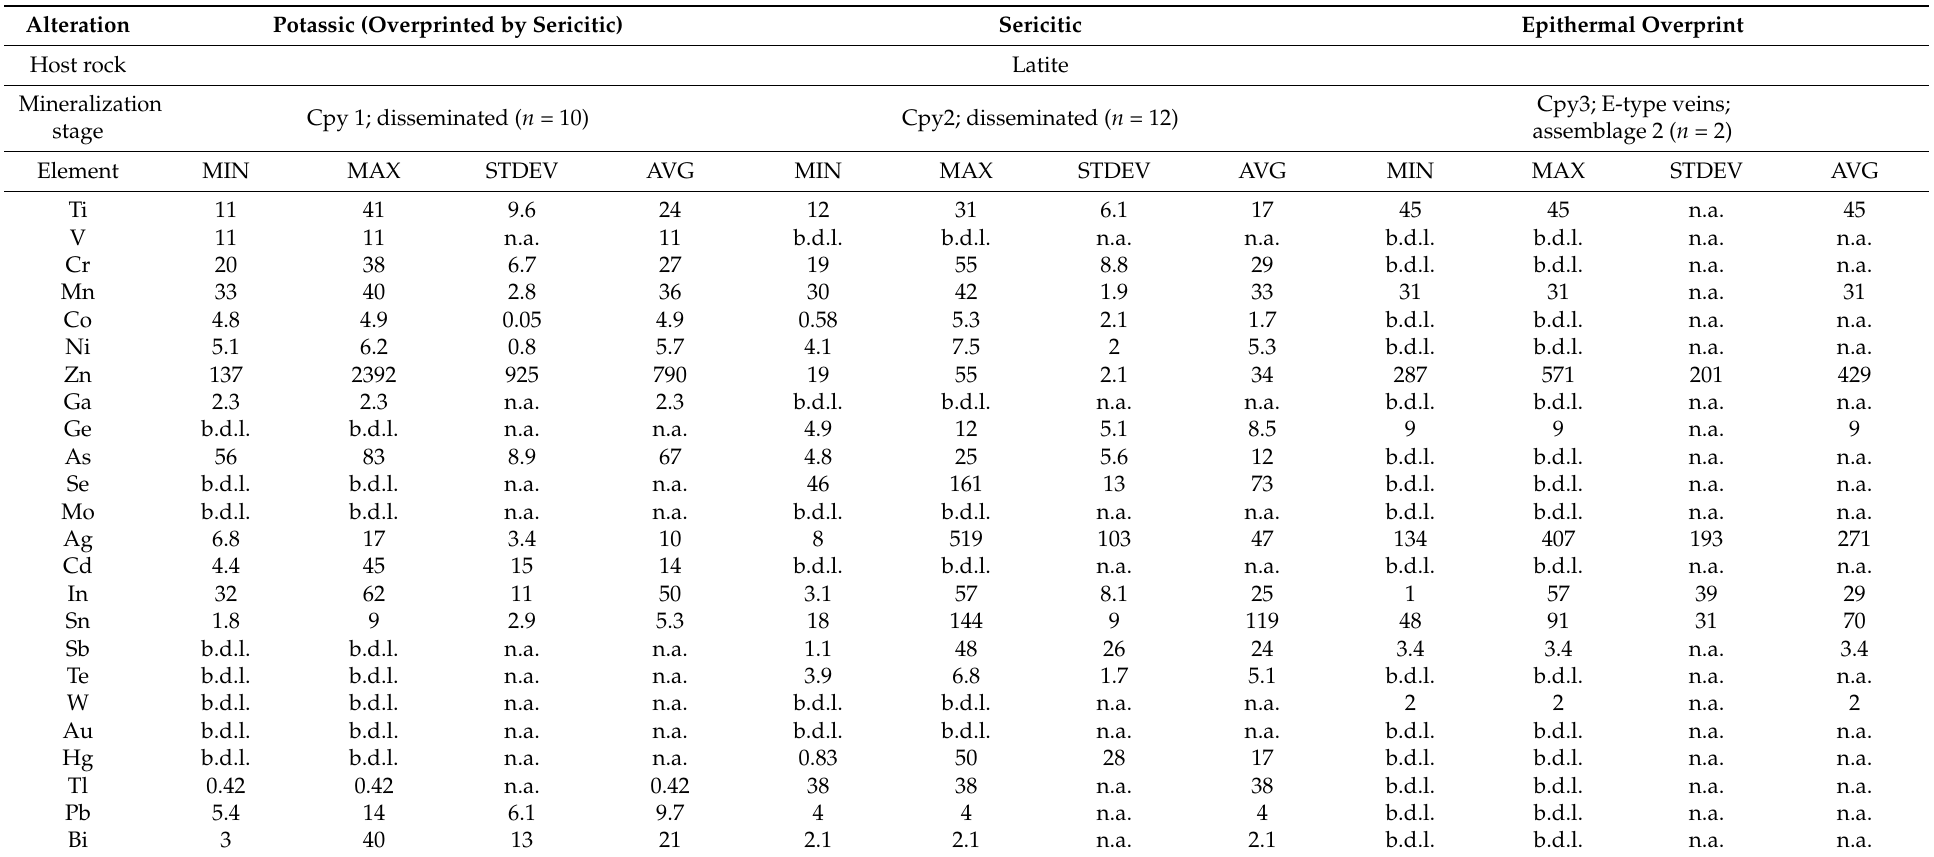
Table 4. LA-ICP-MS analyses of chalcopyrite from various mineralization stages. Values are in ppm. For the full dataset, see Supplementary Table